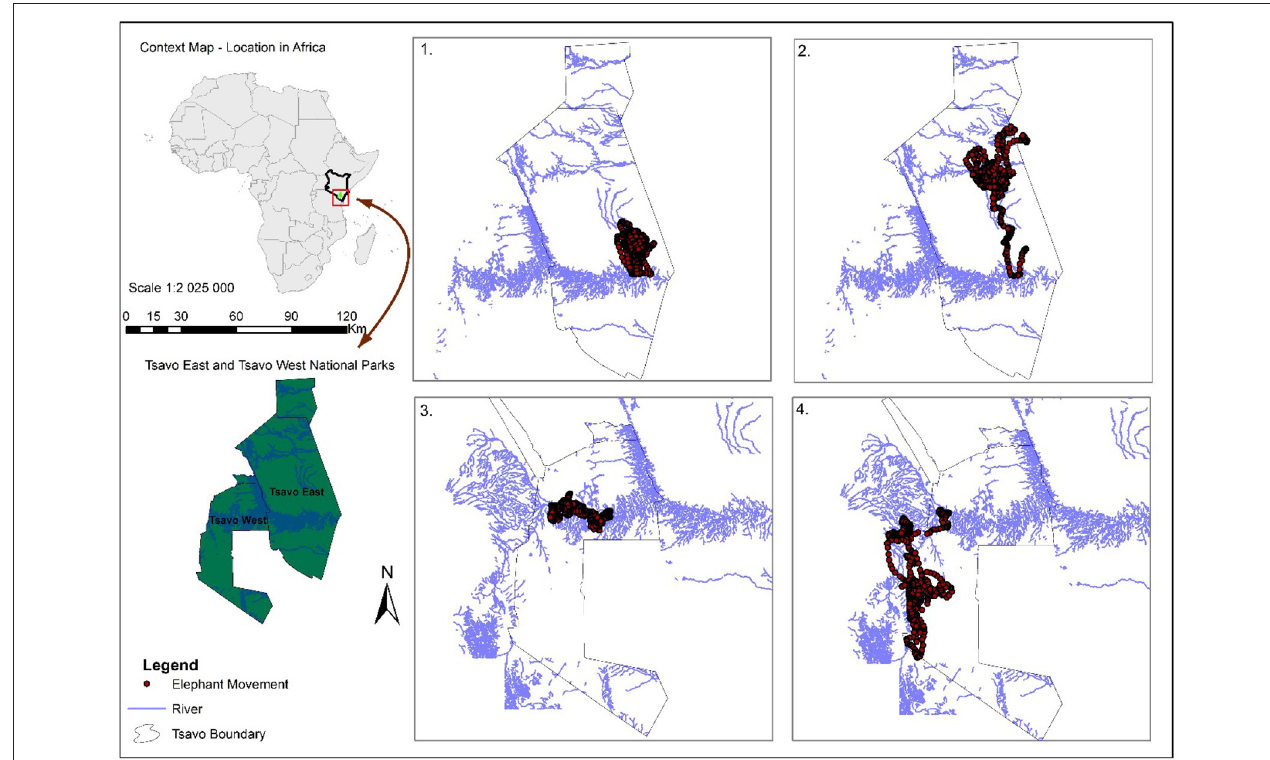
FIGURE 1 | Study areas and the hourly GPS fixes (black dots) for a male elephants in the dry (1) and the wet season (2) ; and for a female elephants in the dry (3) and the wet season (4) . In both sexes the individuals’ movement paths seem to be tightly anchored on a river in the dry